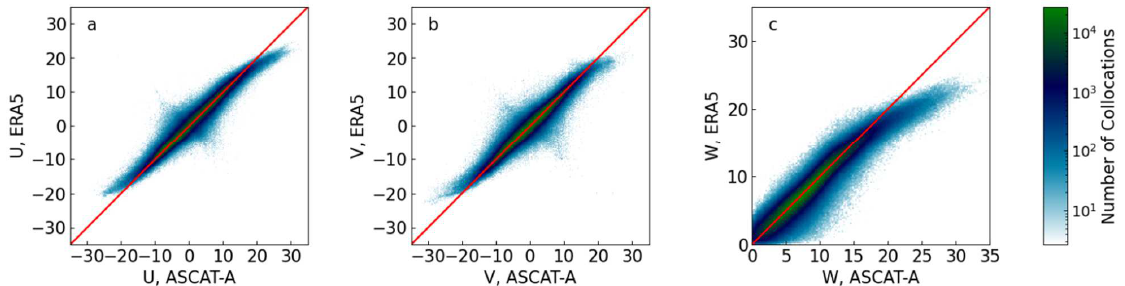
Figure 2. 2-D histograms of zonal wind (U) ( a ), meridional wind (V) ( b ) and wind speed (W) ( c ) for current-correct ERA5 and ASCAT-A for an example month, January 2015. Above about 17 m/s, ERA5 wind speed are systematically lower than ASCAT-A wind speed. A very similar pattern is seen in the vector components, motivating the use of a multiplicative adjustment. Note that the color scale is logarithmic to make areas with relatively low number of collocations easy to see at the expense of making the overall scatter away from the diagonal appear wider. The features in ( a , b ) roughly perpendicular to the diagonal do not contain many collocations. These are likely caused by relatively rare, incorrect selections for the correct “ambiguity” in the wind direction in the scatterometer